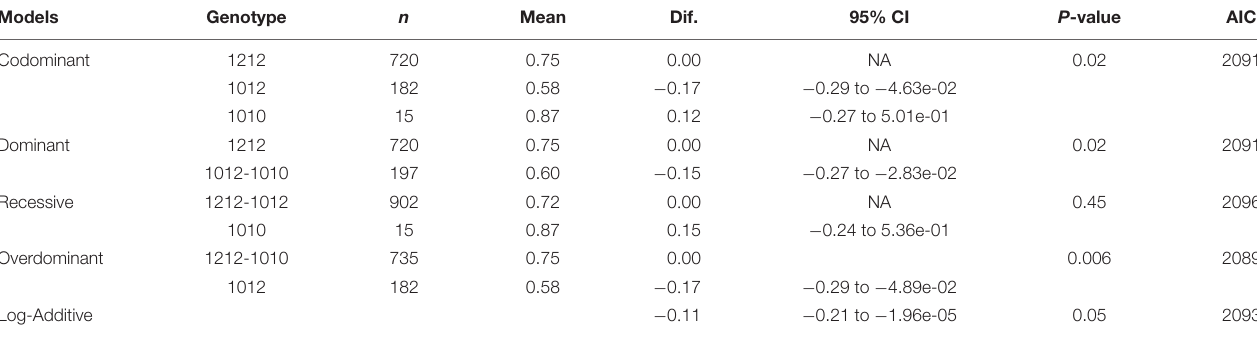
TABLE 4 | After stratification for the HTTLPR genotypes, the association of STin2 polymorphism with the F4 question in the Fagerström Test for Nicotine Dependence, “How many cigarettes per day do you smoke?” became more significant. Results from stratum S/S are presented.